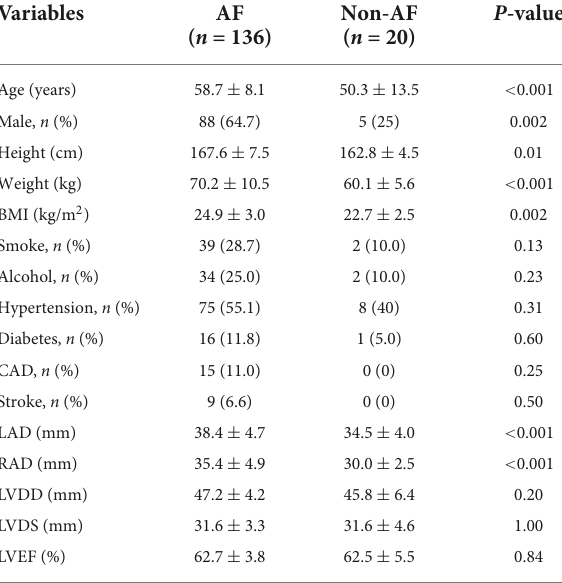
TABLE 1 Baseline characteristics of patients with PAF and PsAF. TABLE 2 Baseline characteristics of patients with AF and